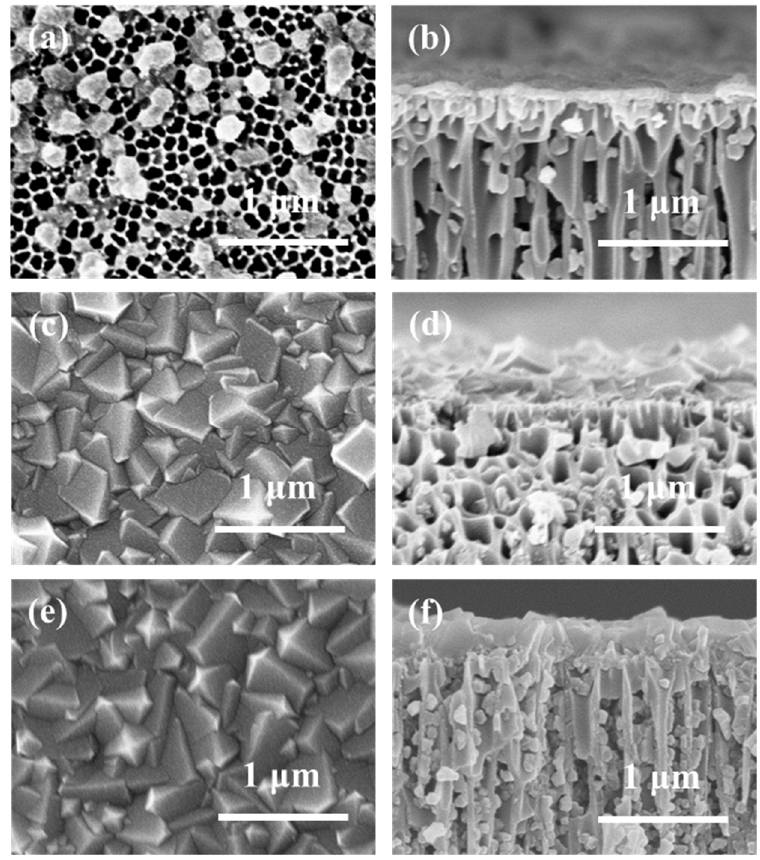
Figure 10. SEM images of ZIF-8/AAO membranes with different deposition times, in which the left images show the surface morphology and the right images show the cross-section morphology: ( a , b ) 20 min, ( c , d ) 40 min, ( e , f ) 60 min (deposition current: 0.65 mA/cm 2 ).